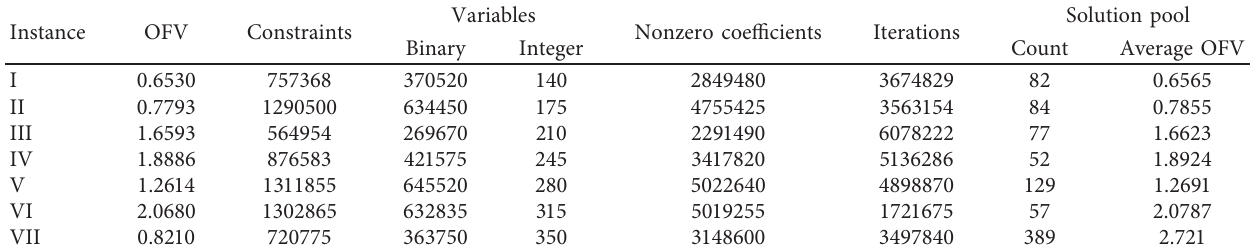
Table 3: The solving statistical information with BYIS-SDTT or BYIS-ADTT by CPLEX.